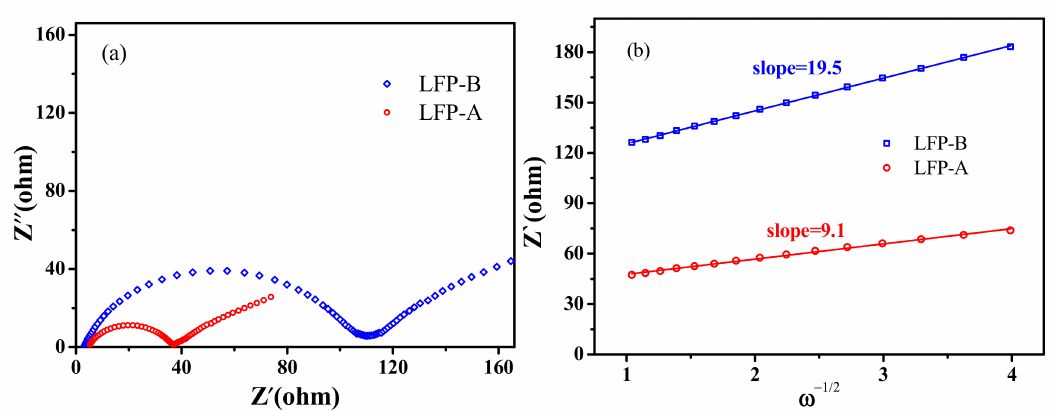
Figure 9. ( a ) Electrochemical impedance spectroscopy (EIS) of the two composites and ( b ) the relationships between Z’ and ω − 1/2 in low-frequency